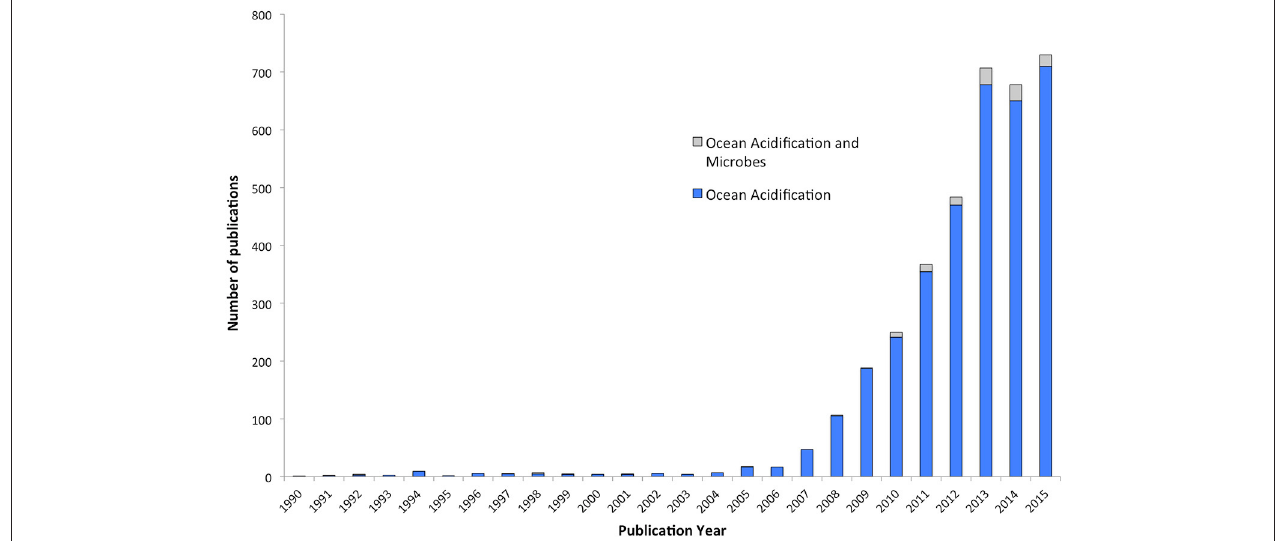
FIGURE 1 | Number of publications based on the key words [ocean acidification] and [ocean acidification and microbes] or [ocean acidification and microorganisms] or [ocean acidification and bacteria], as searched through the Web of Science database. Research on OA has increased dramatically in the past decade, however, little research has been directed toward the implications of OA for